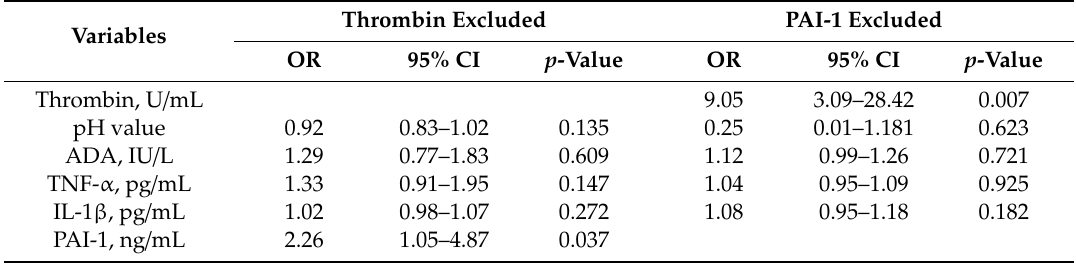
Table 3. Multivariate logistic regression analyses of factors associated with RPT > 10 mm among TBPE patients ( n = 24).